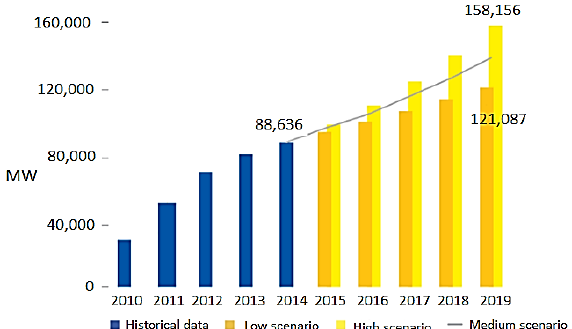
Figure 1. European cumulative solar PV market scenarios until 2019 [5].